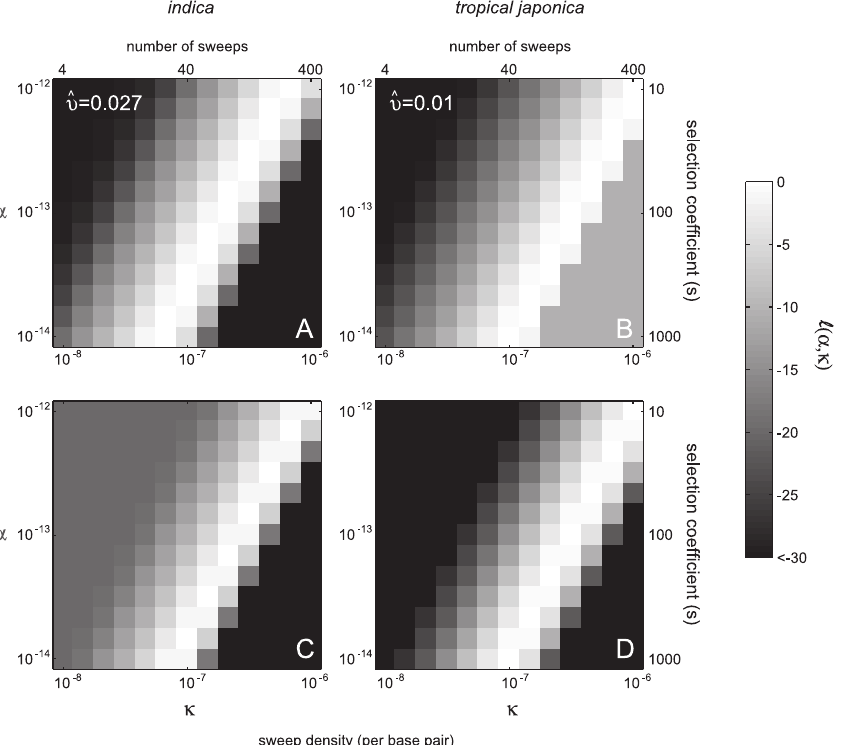
Figure 5. Composite Likelihood Surfaces in indica and tropical japonica under Models Incorporating Selection A density plot of the marginal composite log-likelihood surface of the parameters a and j , with the bottleneck severity t fixed to its estimate, under the bottleneck plus sweeps model for (A) indica and (B) tropical japonica . The composite log-likelihood surface of the parameters a and j under the pure selection model for (C) indica and (D) tropical japonica . The composite log-likelihood is represented as a deviation from the maximum log-likelihood, with lighter values representing higher composite likelihoods. Numbers above (A) and (B) indicate the total number of sweeps in the rice genome corresponding to each value of j , and numbers to the right of (B) and (D) represent the selection coefficient, s , corresponding to each value of a , substituting an effective recombination rate of r ¼ 10 (cid:2) 12 and ln(2 N ) ¼ 10 into the expression: a ’ rs (cid:2) 1 ln(2N), then solving for s